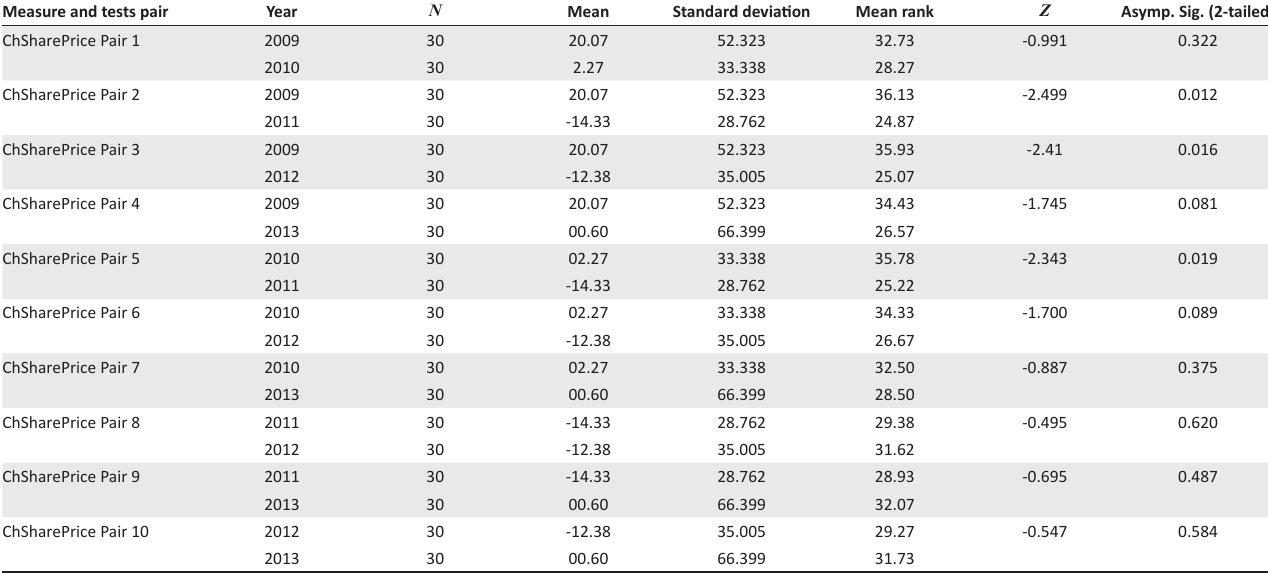
TABLE 1: Mann–Whitney test results – Change in share price. Measure and tests